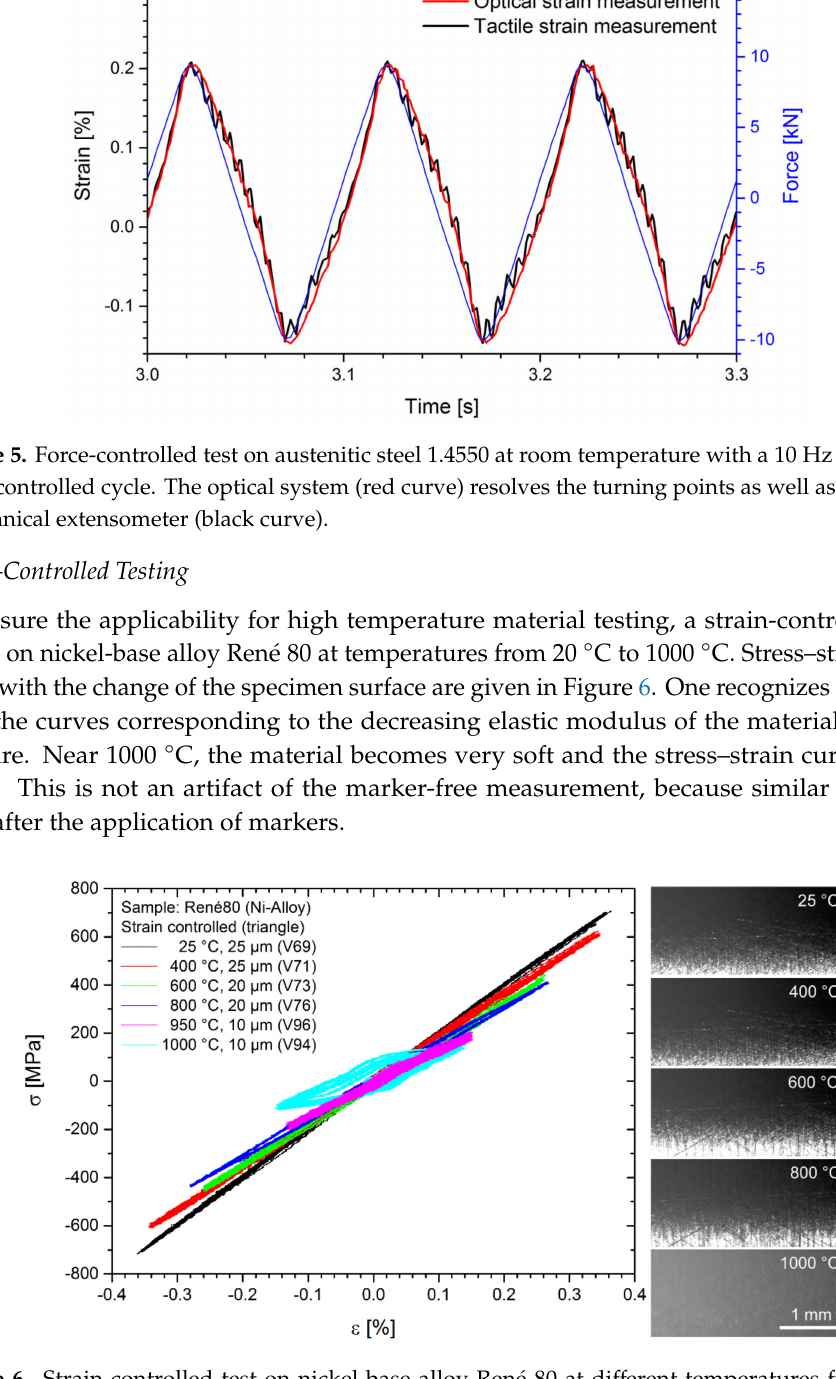
Figure 6. Strain-controlled test on nickel-base alloy Ren é 80 at di ff erent temperatures from room temperature to 1000 ◦ C. The specimen surface changes with increasing